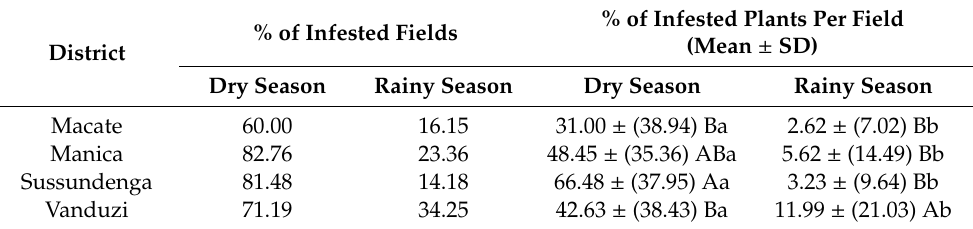
Table 1. Percentage of infested fields and average infestation of plants per field, district, and season of